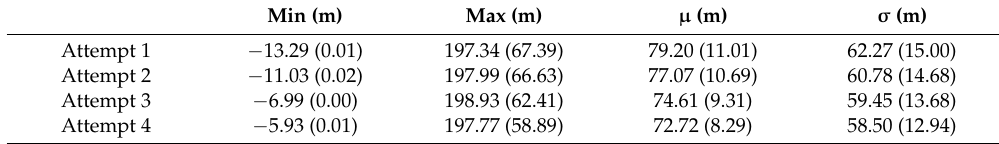
Table 5. Results of the flight path deviation for the SITL experiment with a 15 m/s UAV speed.